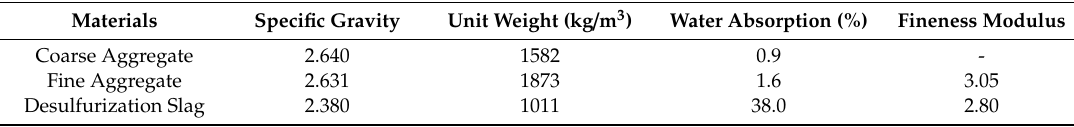
Table 2. The physical properties of the materials.